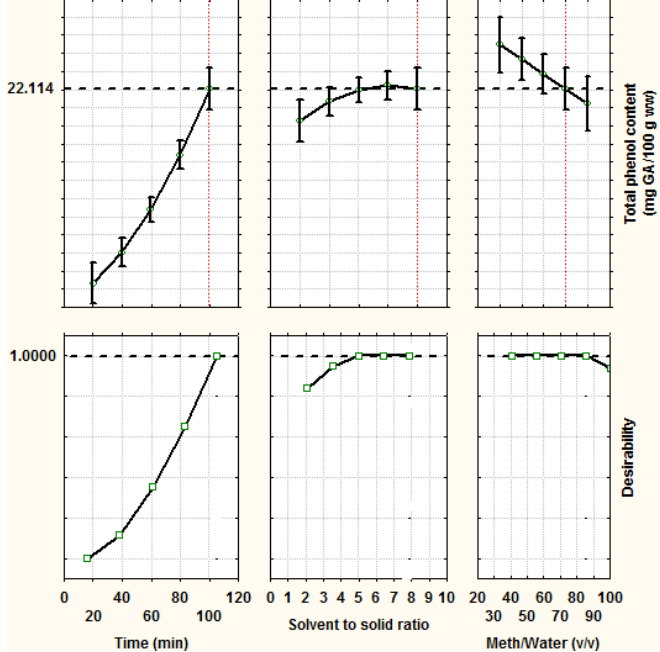
Figure 1. Predicted total phenol content and desirability level for different variables of optimum polyphenol extraction from green leek leaf extracts.